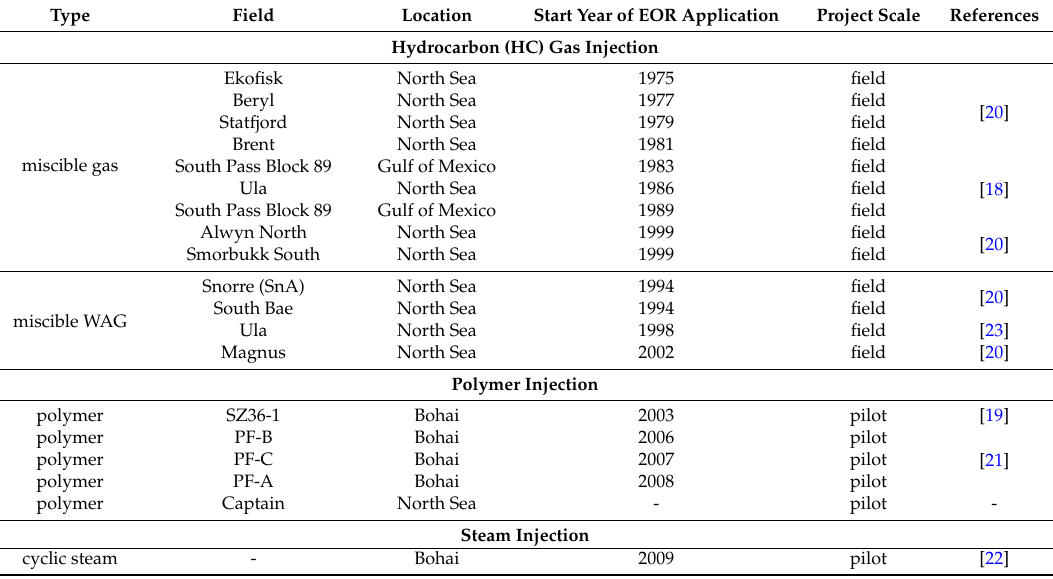
Table 1. Successful enhanced oil recovery (EOR) application cases in offshore fields.